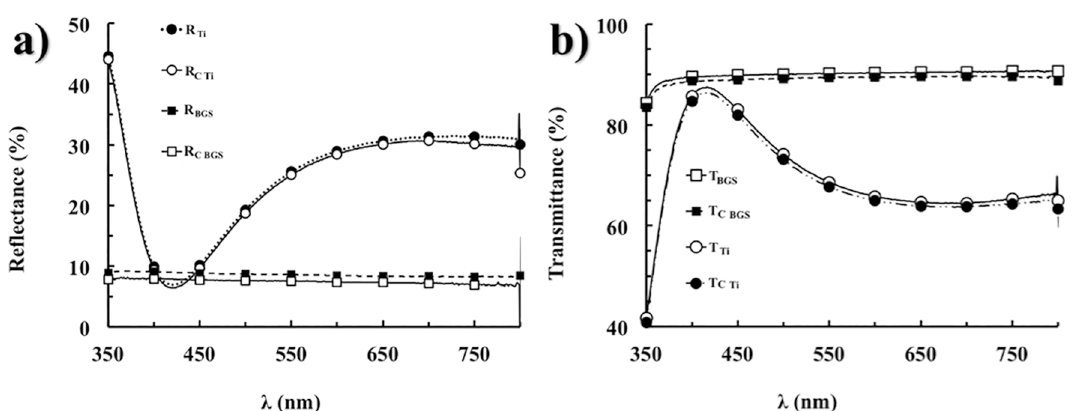
covered BGS substrates. a) total (R , R ) and collimated (R 2 BGS Ti , T ) and collimated (T , T ) components of transmittance spectra. Total components are BGS Ti C BGS C Ti